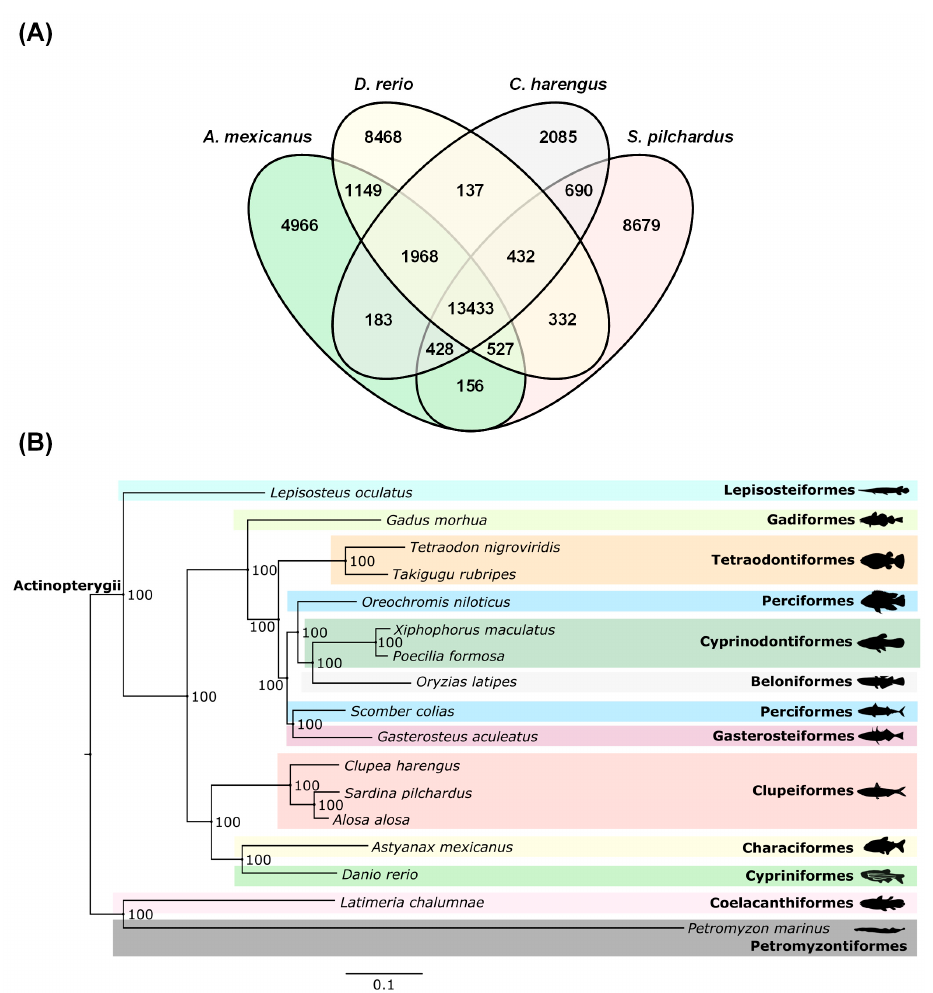
Figure 2. Genome evolution and phylogenomics. ( A ) Orthologous gene families across four fish genomes (European sardine, zebrafish, herring and blind cave fish). ( B ) Phylogeny of vertebrates (lamprey as the outgroup species); numbers at nodes represent bootstrap values.